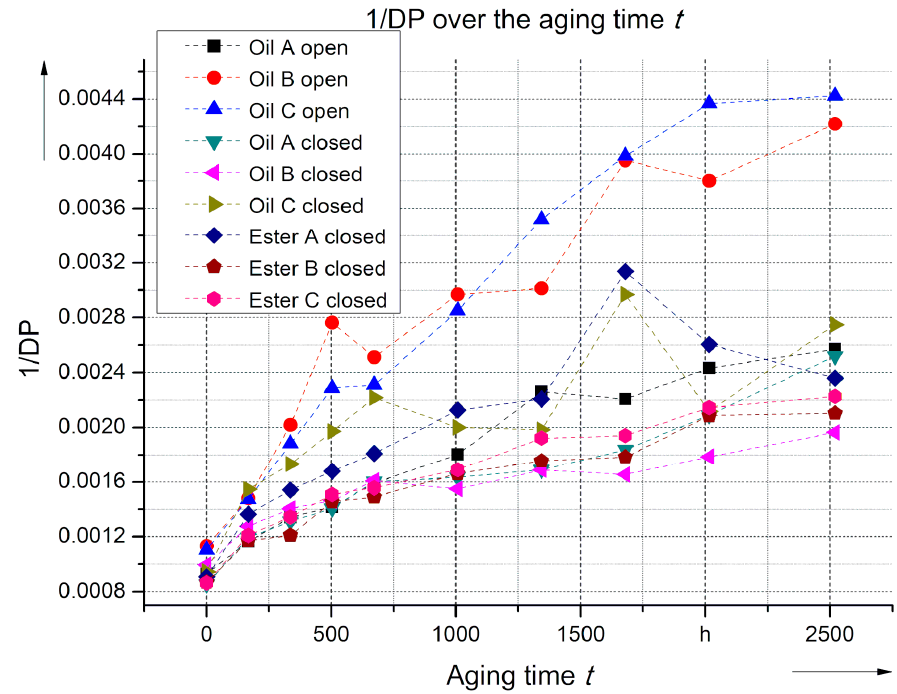
Figure 5. Rate of depolymerization in 1/DP over the aging time for different systems and liquids.